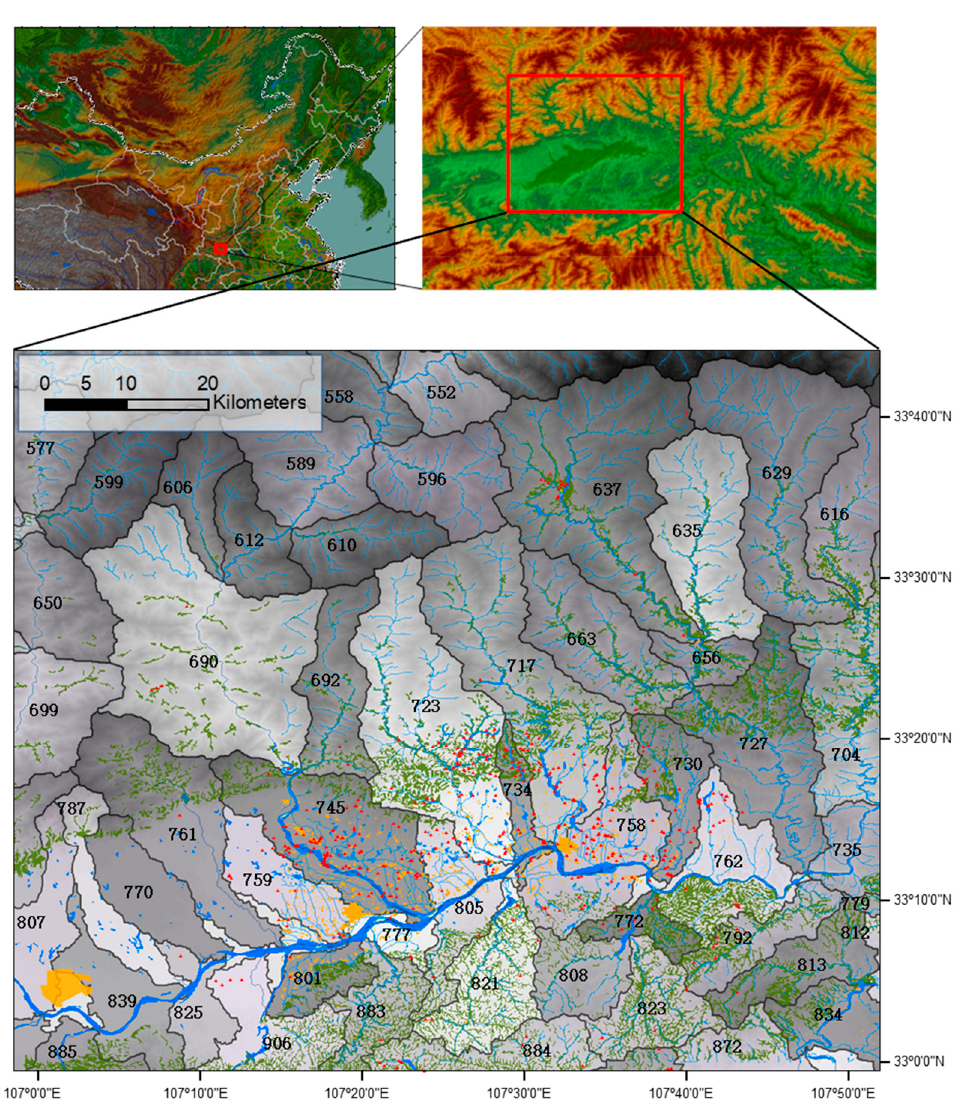
Figure 1. The spatial distribution of crested ibis nest sites in 2019 (red triangles). The upper right panel shows the elevation of the study area, ranging from 400 to 1800 m. In the bottom panel, the polygons in grey colors are watersheds; the green areas represent rice paddies; the blue areas represent water bodies (rivers, lakes, and ponds); and the brown areas are human residences.